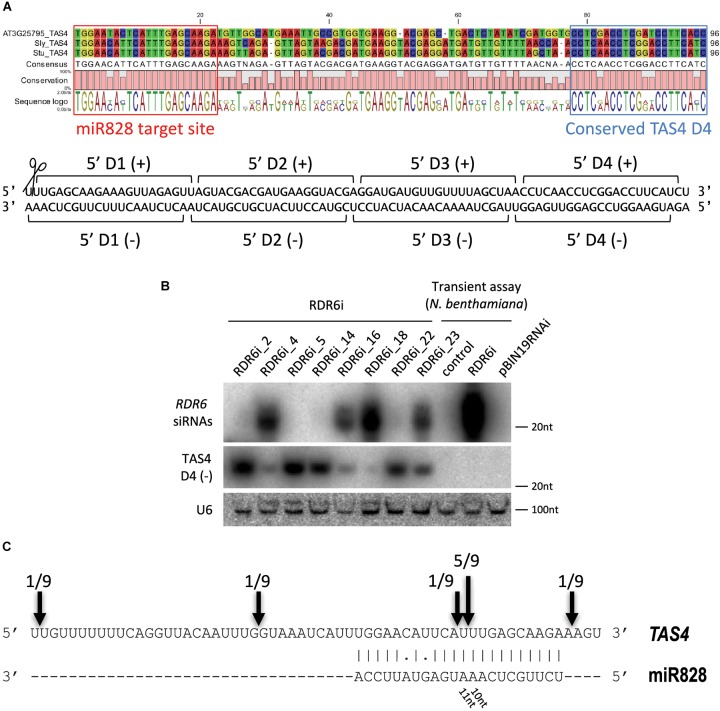
Analysis of potato TAS4. (A) Sequence alignment of TAS4 sequences of Arabidopsis thaliana, tomato and potato; the miR828 target site and TAS4 D4(-) are marked. Below the alignment the double stranded (ds) DNA sequence shows the cut TAS4 RNA with the first four phased siRNAs. (B) RNA gel blot analysis of RDR6i lines; Nicotiana benthamiana transient assay was used as a control (control: non-infiltrated leaf; RDR6i: leaf infiltrated with RDR6i construct; pBIN19RNAi: leaf infiltrated with empty vector). Radioactively labeled random probe of RDR6 amplicon and probe specific to TAS4 D4(-) were used to visualize RDR6i derived siRNAs and TAS4 D4(-). U6 was used as a loading control. (C) RLM 5′ RACE was used to identify free ends of TAS4 RNA. Arrows and numbers indicate free RNA ends with the frequency of cut points identified; the predominant cut occurs between 10/11 nucleotides of miR828.